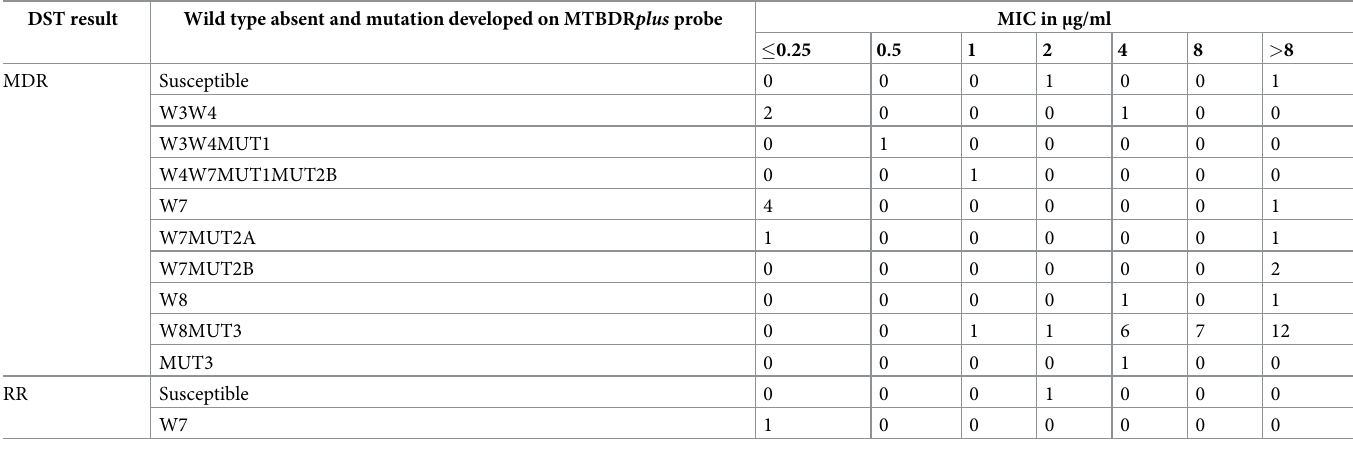
Table 2. Line probe assay result and minimum inhibitory concentration of rifabutin among multidrug resistant (MDR) and rifampin resistant (RR) Mycobacterium tuberculosis